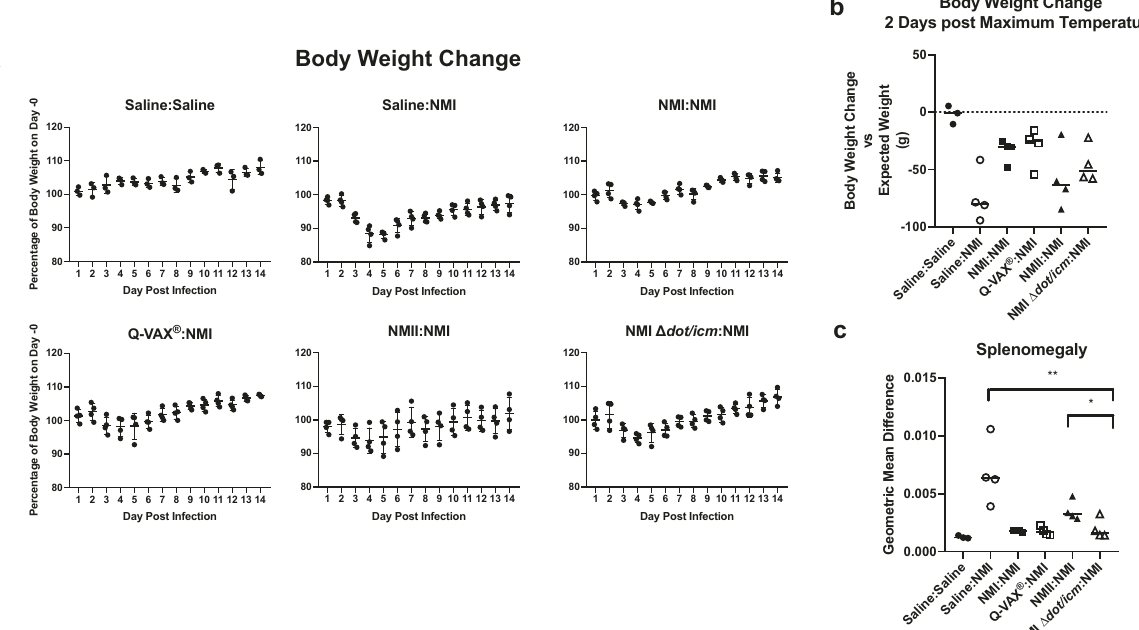
Fig. 6 NMI Δ dot/icm WCV protects guinea pigs against body weight loss and splenomegaly following C. burnetii challenge. a . Guinea pigs were subcutaneously vaccinated with 25 μ g of C. burnetii WCVor Q-VAX ® , or mock infected with saline, then allowed to rest for 28 days. Animals were then intraperitoneally infected with 10 6 GE NMI or mock infected with saline, monitored for 14 days, and euthanized. Body weight change is presented as percentage of body weight gained/lost at any given day compared to day 0 post-infection. b Body weight change at 2 days post maximum temperature is presented as body weight change versus expected weight at the measured time point for each individual animal, with a black dotted line at 0, indicating no change. c At euthanasia (14 days post-infection), splenomegaly was quanti fi ed and data are presented as geometric mean difference of spleen weight normalized to total body weight. Body weight change and splenomegaly were evaluated based on differences in group means (horizontal bar) with associated con fi dence intervals. Error bars represent standard deviation. For each reported comparison, p -values were computed at the α = 0.05 level for two-sided two-sample t tests, allowing for unequal variances between groups. No adjustment was made for multiple comparisons due to the sample sizes ( n = 4 except for Saline:Saline with n = 3) and the descriptive nature of the study. * p ≤ 0.05 and ** p ≤